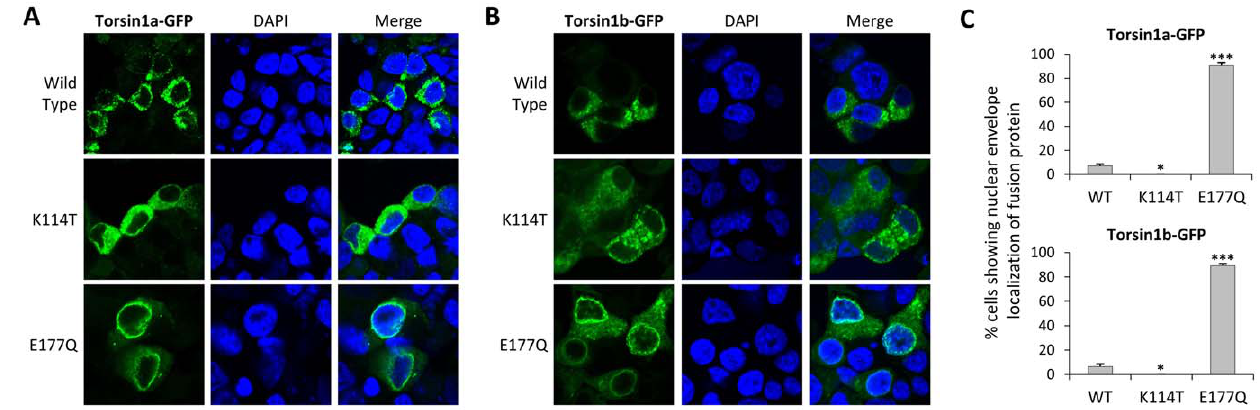
Figure 8. ATP-binding and ATP-hydrolysis mutations in Torsin1 alter cellular localization. MN9D cells were transfected with expression plasmids encoding either (A) Torsin1a-eGFP or (B) Torsin1b-eGFP fusion proteins. The images show single confocal planes through transfected cells demonstrating GFP fusion protein localization (green, left column) relative to the nucleus (DAPI counterstain, blue, center column). For each panel, the top row of images shows wild type Torsin1, the middle row of images shows a Torsin1[K114T] mutant, which disrupts the Walker A (ATP-binding) domain, and the bottom row shows a Torsin1[E177Q] mutant, which disrupts the Walker B (ATP hydrolysis) domain. (C) Four independent samples for each construct were evaluated for nuclear envelope localization of the fusion protein. The graphs show the mean % cells with nuclear envelope localization (100–200 cells were scored for each construct; error bars show standard error; ***P , 0.0001, *p , 0.05 versus WT, heteroscedastic 2-tailed T-test with Bonferroni